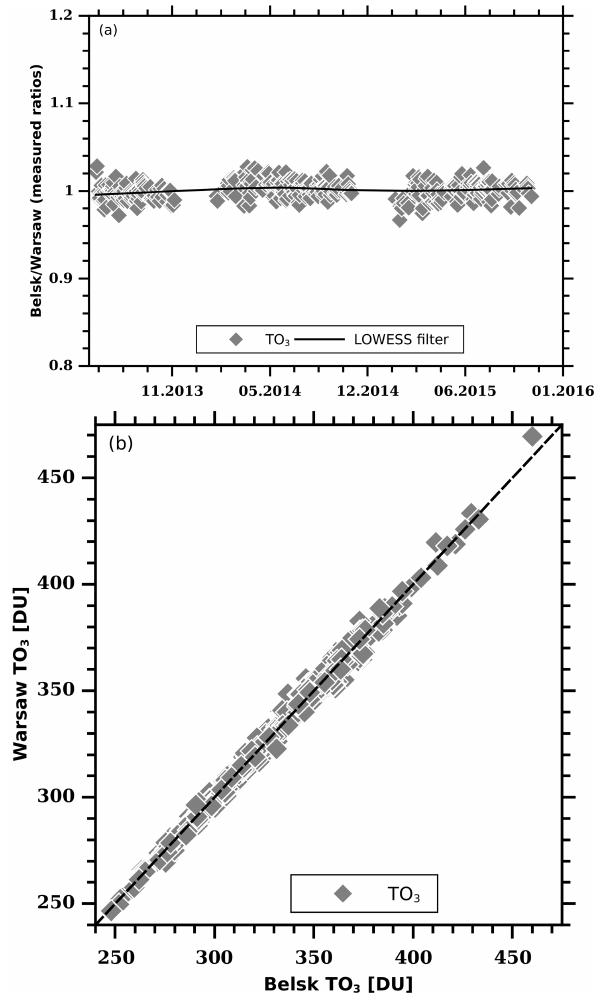
Figure 7. (a) The ratio between total ozone values measured by Brewer spectrophotometers Nos. 64 and 207 while working si- multaneously at Belsk and in Warsaw for the period May 2013– December 2015. The solid curve represents the data smoothed by the LOWESS filter. (b) Scatter plot of total ozone values mea- sured by Brewer spectrophotometers Nos. 207 and 64 while work- ing simultaneously in Belsk and Warsaw from May 2013 to Decem- ber 2015.